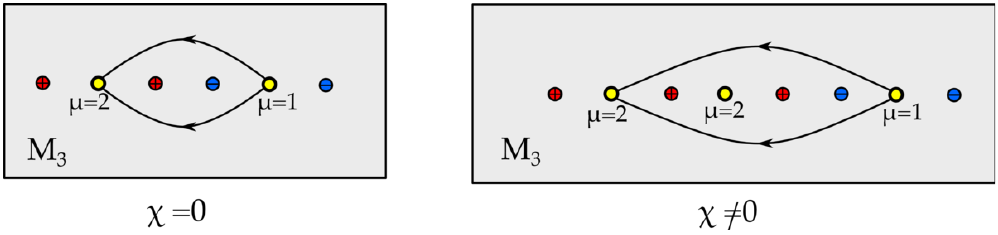
Figure 5 . Examples of point like charge con(cid:12)gurations in M 3 . Depicted are positive (red) and negative (blue) charges, critical points (yellow) and (cid:13)ow lines starting and ending at critical points. The critical points have Morse index (cid:22) . The contributions of the (cid:13)ow lines cancels and for generic set-ups each critical point will give rise to a ground state of positive, negative chirality if (cid:22) = 1 ; 2 respectively. The l.h.s. thus has an equal number of chiral and conjugate-chiral ground states, the chiral index vanishes. For the same reasons the chiral index does not vanish on the r.h.s.